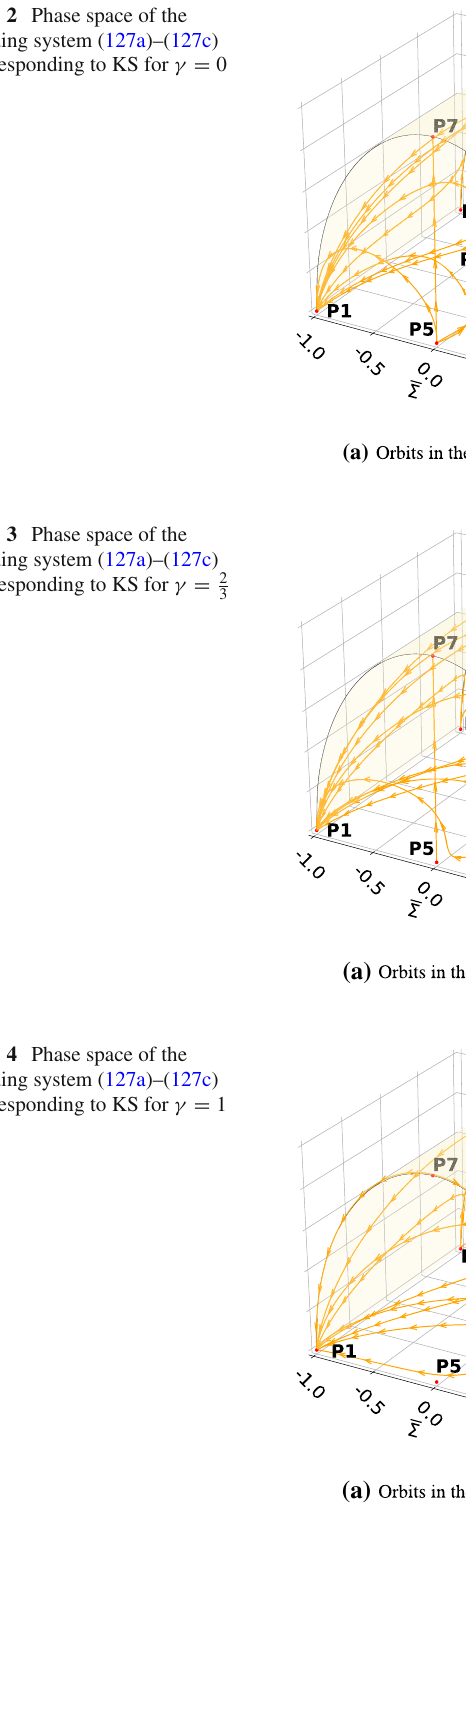
Fig. 3 Phase space of the guiding system (127a)–(127c) corresponding to KS for γ = 2